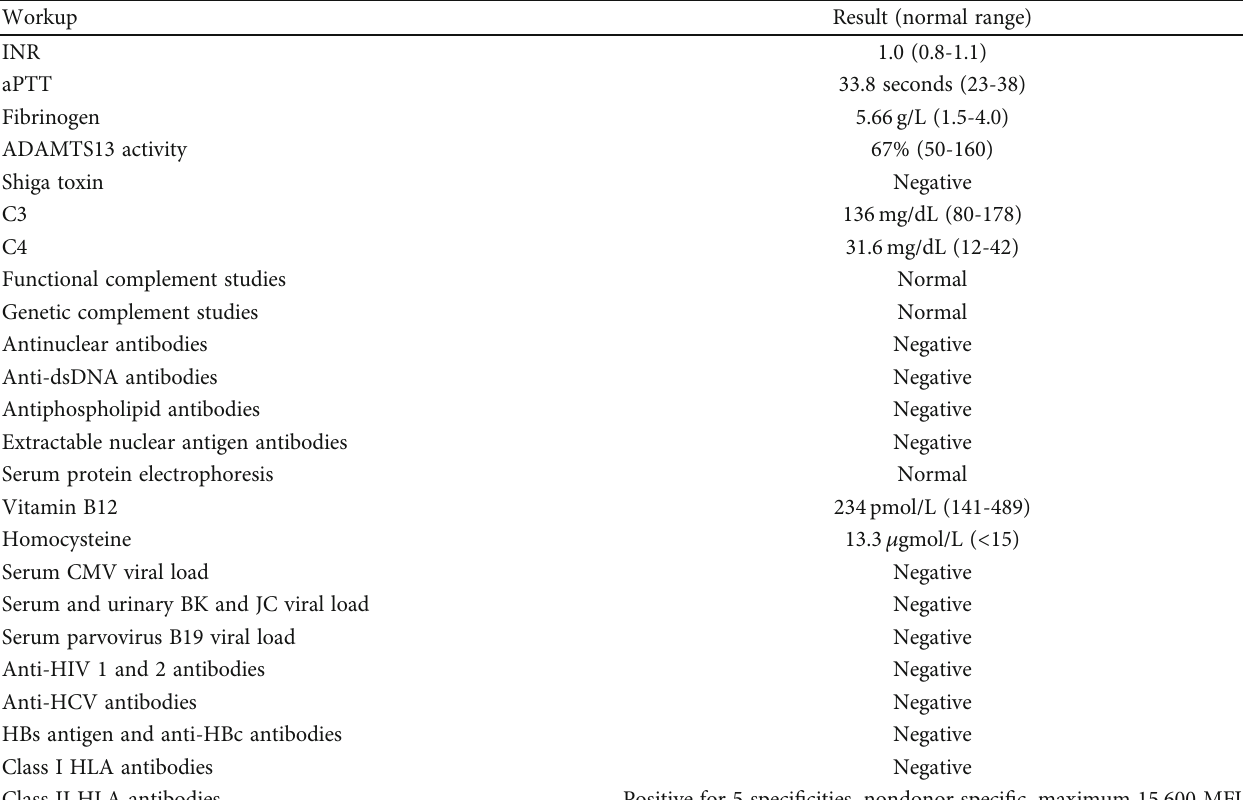
Figure 1: Thrombotic microangiopathy evolution. MTH-EAR: months earlier; Disch: discharge; MTH-FW: months follow-up; Hb: hemoglobin; Ptl: platelets; LDH: lactate desidrogenase; Creat: creatinine. Analytical values presented as hemoglobin in g/dL, platelets in 10 4 /uL, LDH in 10 2 U/L, and creatinine in Table 1: Thrombotic microangiopathy workup.